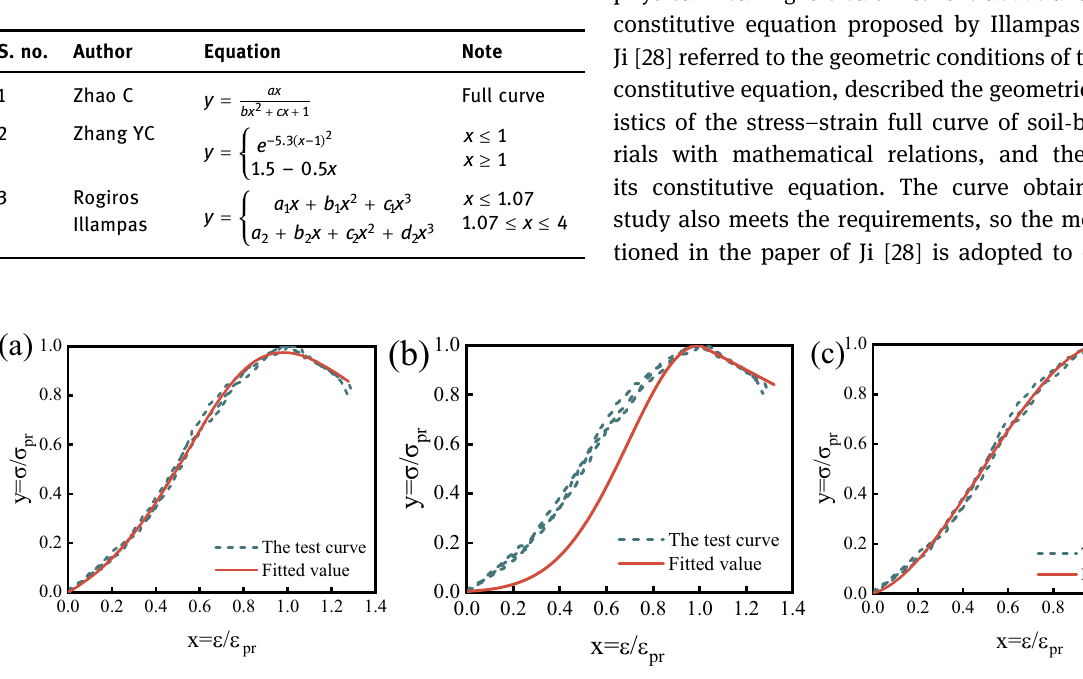
Table 5: Constitutive equation of raw soil material